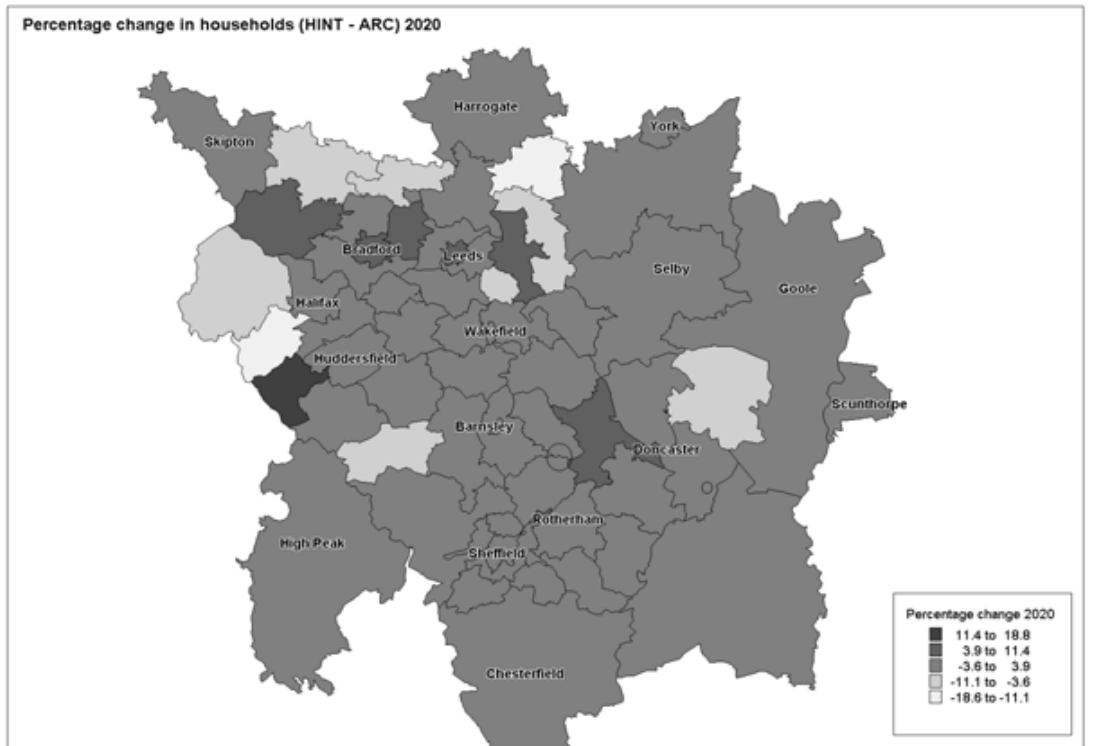
Figure 6. HINT package: impact on households,